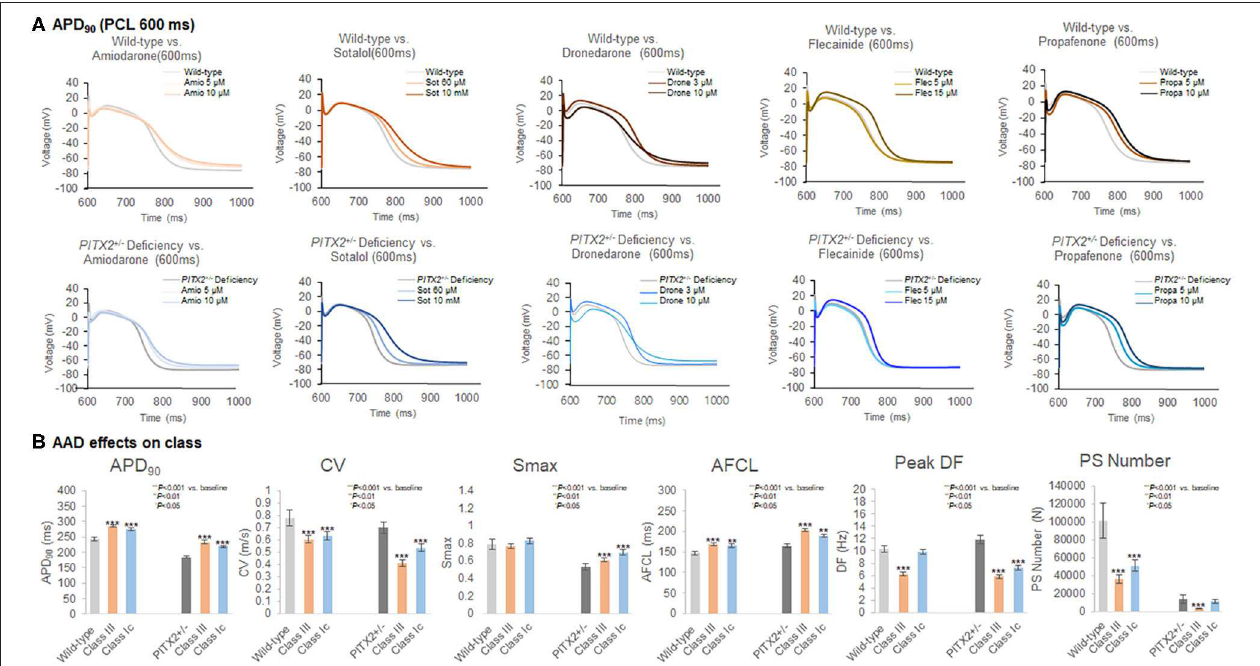
FIGURE 3 | Characteristics of the wild-type and PITX2 + / − deficiency with the response to AADs. (A,B) The APD 90 , CV, Smax, AF cycle length, and wave-dynamics parameters were compared with baseline after AADs. (B) Both class III and class IC increased APD 90 , and AFCL in wild-type and PITX2 +−− deficiency model. Class III and class IC decreased CV in wild-type and PITX2 + / − deficiency model while both classes increased Smax in PITX2 + / − deficiency model.